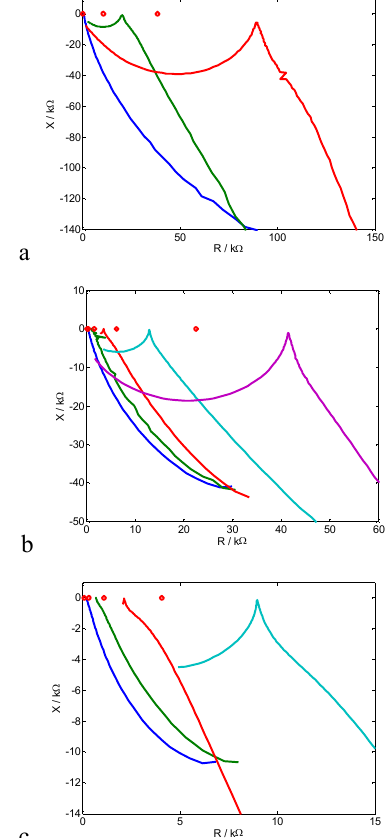
Fig.14: Impedance of gold electrodes in PBS of different concentration and different surface area: a) A = 1 mm 2 , concentration from left to right: 140 mM, 2.18 mM 0.55 mM b) A = 4 mm 2 , c = 140 mM, 35 mM, 8.75 mM, 2.18 mM, 0.55 mM and c) A = 16 mm 2 , c = 140 mM, 35 mM, 8.75 mM, 2.18 mM. The red circles show the resistance estimated from the conductivity of the electrolyte and the geometry of the chamber inclusively the spreading resistance in series with the charge transfer resistance got from cyclic voltammetry. The resistance of the counter electrode was taken into account as well but it was small with only few percent of the charge transfer resistance.